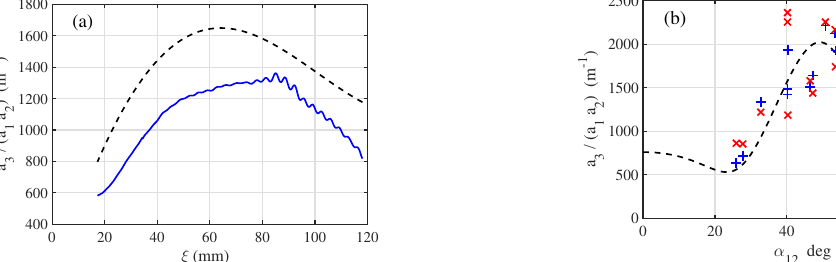
Figure 12. From Cazaubiel et al. [42]. ( a ) For the triad f 1 = 15, f 2 = 18 and f 3 = 33Hz; spatial evolution of the daughter wave amplitude a 3 rescaled by the product of the average amplitude of (cid:104) a (cid:105) the mother waves (cid:104) a 1 (cid:105) d 2 d 2 as a function of ξ , the distance to the beginning of the interaction 1 zone for α 12 = 40 ◦ . The amplitude of the mother waves have been averaged on the study domain. The theoretical solution in the dashed line is given by the amplitude equation for the daughter wave. ( b ) Local value of the daughter wave amplitude a 3 , rescaled by the product of the mother wave amplitude a 1 a 2 for ξ = 80mm a 3 ( ξ = 80mm ) , depicted as a function of α 12 . Blue + —rescaling by the average amplitude of the mother waves inside the interaction zone. Red × —rescaling by the local amplitude of the mother waves a 1 ( ξ = 80mm ) a 2 ( ξ = 80mm ) . The typical variation between the points is about 20%. The prediction of the model for ξ = 80mm is plotted in dashed black line. (Reprinted with permission from Ref. [42] Copyright 2022 American Physical